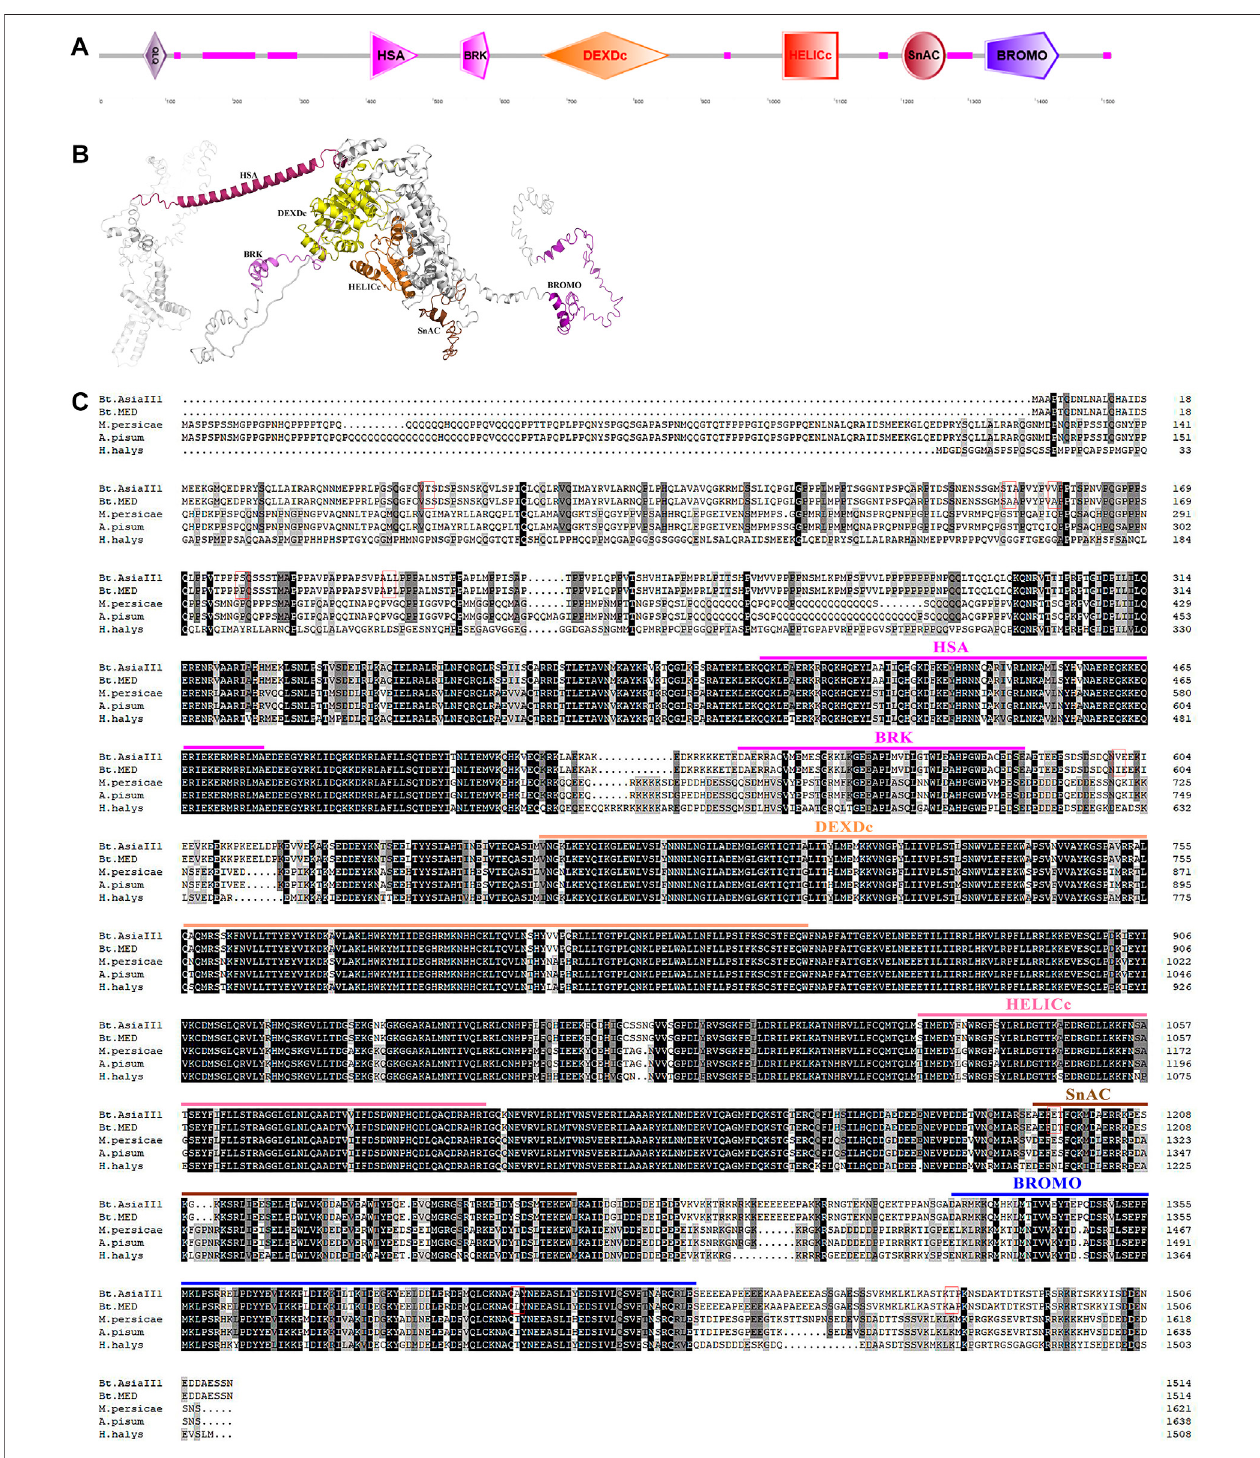
FIGURE3| Conserved domainsofBt-BRM-2in Bemisiatabaci . (A) FunctionaldomainsinBt-BRM-2protein. (B) ThepredictedtertiarystructureofBt-BRM-2. (C) Multiple alignments of the BRM protein from white fl ies and other insects. The conserved domains are highlighted in different colors and the amino acid sites that vary between MED and Asia II 1 are marked with red rectangles. Bt. Asia II 1: Bemisia tabaci Asia II 1; Bt. MED: Bemisia tabaci MED; M. persicae: Myzus persicae (XP_022166801.1); A. pisum: Acyrthosiphon pisum (XP_001947872.2); and H. halys: Halyomorpha halys (XP_014292008.1).